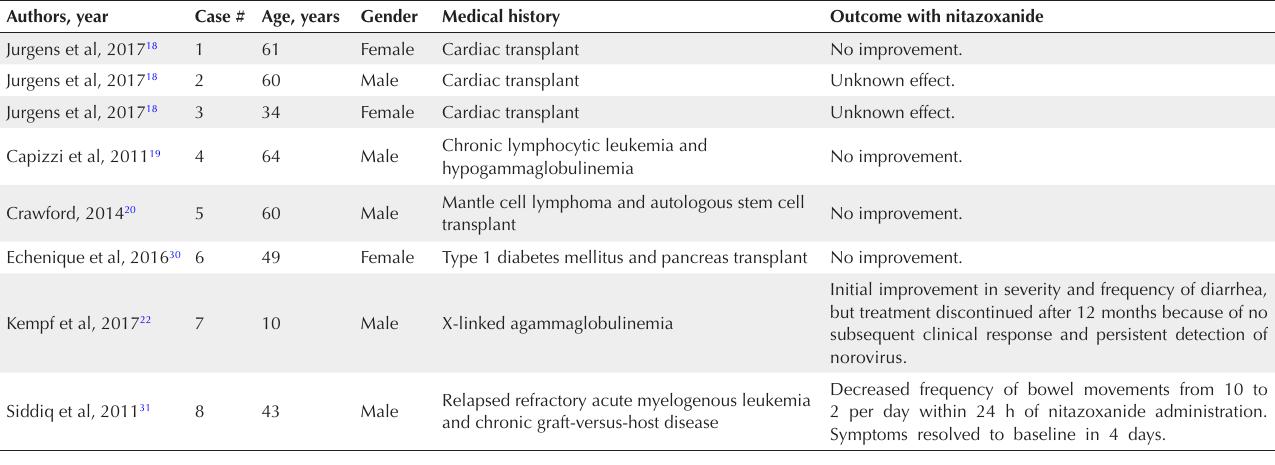
Table 3. Case Reports on Nitazoxanide for Norovirus